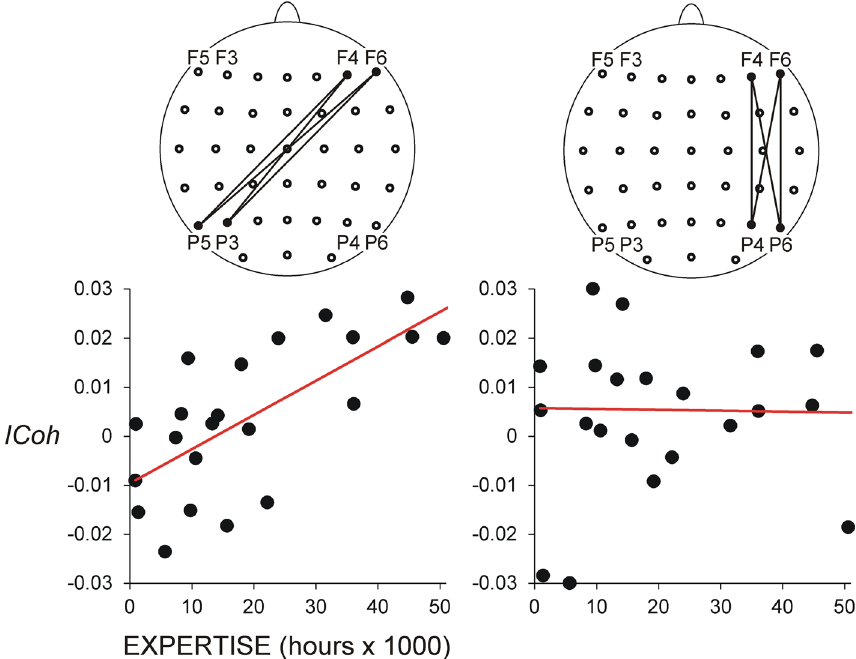
Figure 3. Correlation between fast alpha (12–15 Hz) ICoh and meditation expertise. Individual difference ICoh values are presented (meditation minus rest); FAM, OMM and LKM pooled together for each individual difference ICoh value. Y-axis—non-dimensional ICoh difference values. The meditation-related inter- hemispheric linear increase of fast alpha ICoh as a function of meditation expertise is depicted on the left for right frontal (F4, F6)—left parietal (P3, P5) electrode pairs. The lack of correlation between meditation-related intra-hemispheric modulation of fast alpha ICoh as a function of meditation expertise is shown on the right.